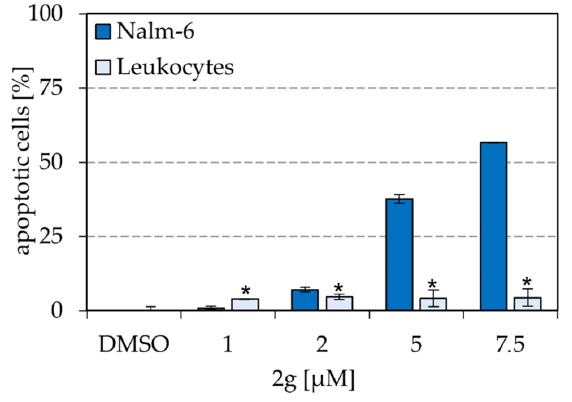
Figure 9. Selectivity of 2g . Nalm-6 cells and healthy human leucocytes (ex vivo) were treated with different concentrations of 2g for 72 h. As the solvent, control cells were treated with the same amount of DMSO as used for 2g . After treatment, the induction of apoptosis was measured via flow cytometric analysis of DNA fragmentation. Three replicates were carried out per concentration. The mean values ± SD are shown (* p < 0.05 vs. corresponding concentration in Nalm-6, t -test).